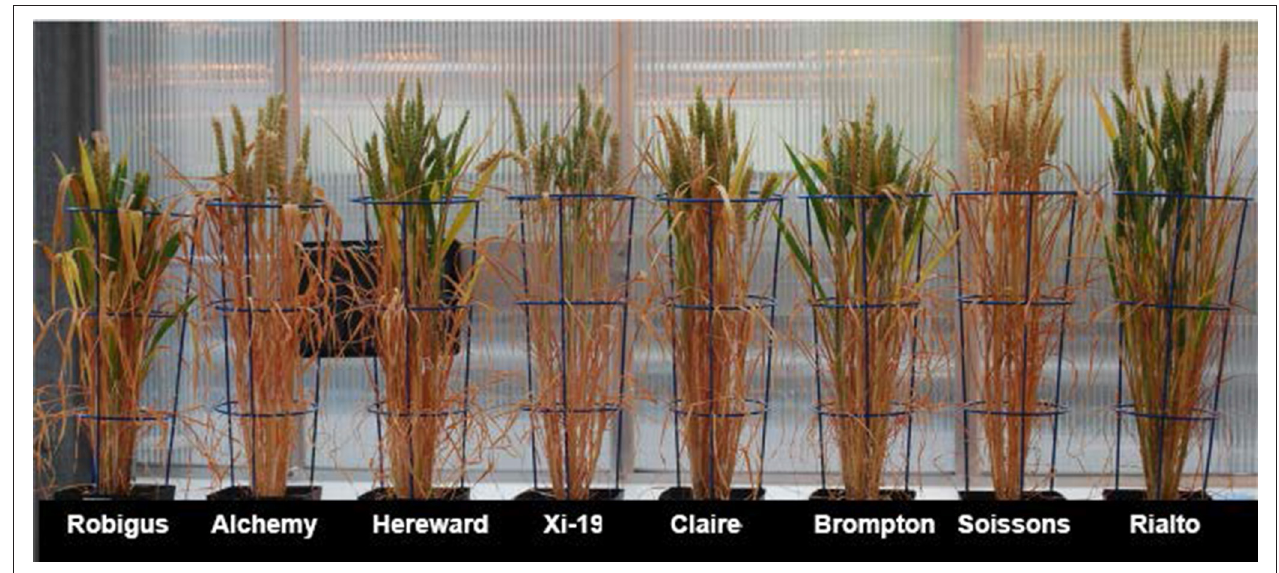
FIGURE 2 | MAGIC parents at